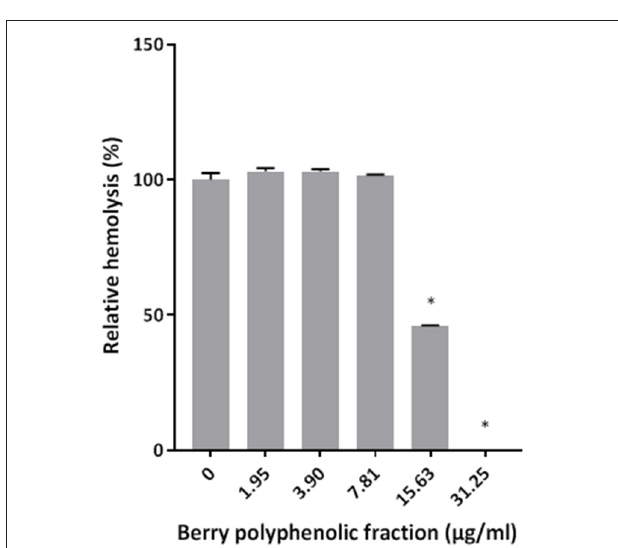
FIGURE 2 | Effect of the berry polyphenolic fraction on the hemolysis of sheep red blood cells by P. gingivalis . A relative value of 100% was assigned to the hemolysis of sheep red blood cells in the absence of the berry polyphenolic fraction. Results are expressed as the means ± SD of triplicate assays from three independent experiments. *Significant inhibition ( p < 0.01) compared to the